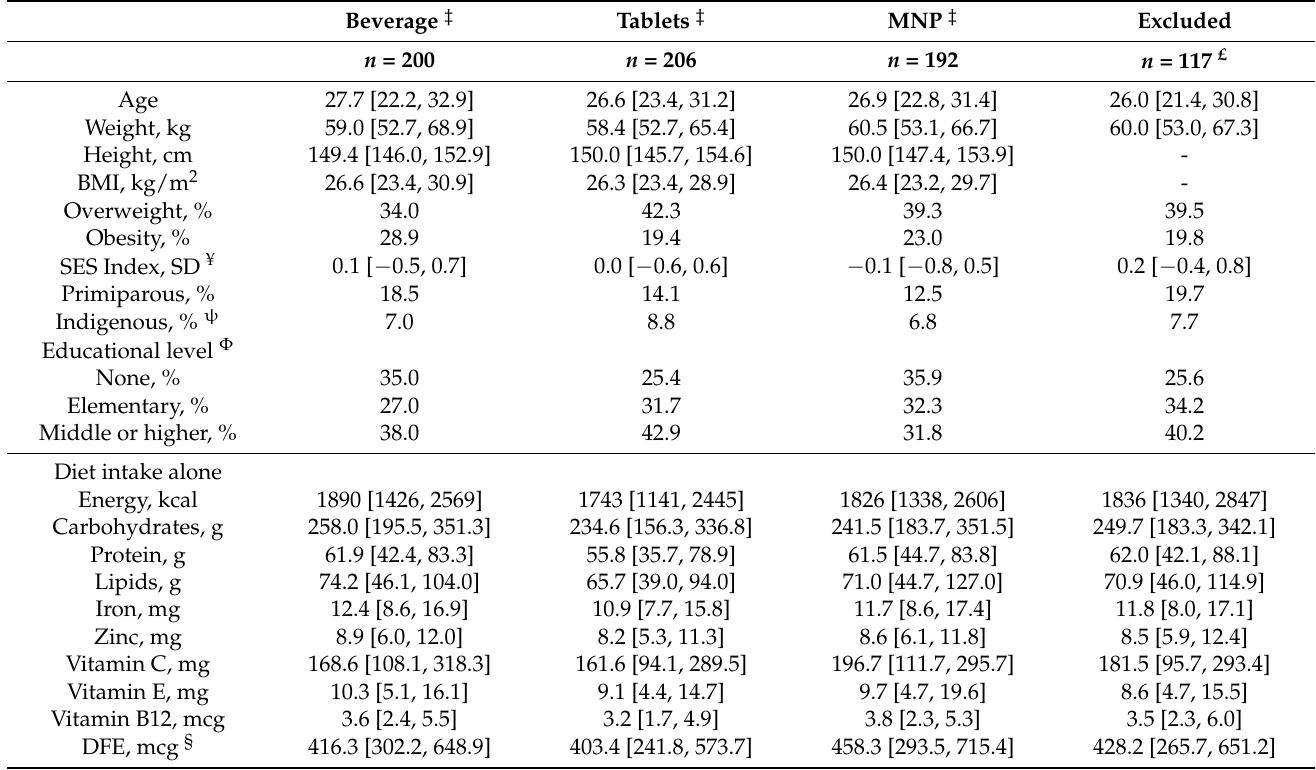
Table 2. Characteristics of the women at baseline † by evaluation study